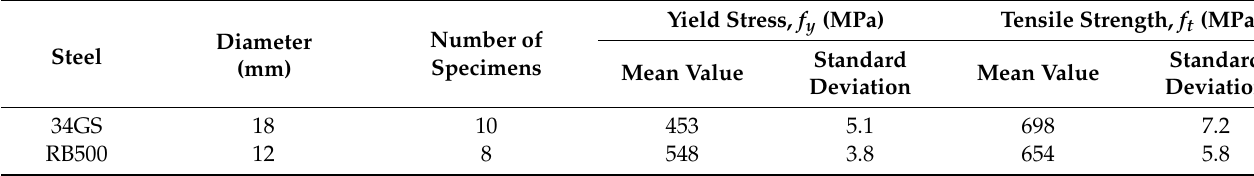
Table 1. Mechanical properties of reinforcing steel.